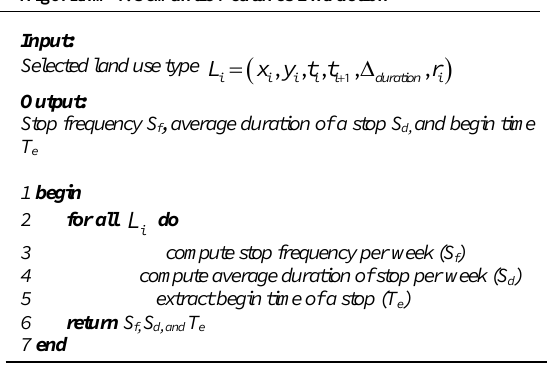
Algorithm 4. Semantic Features Extraction